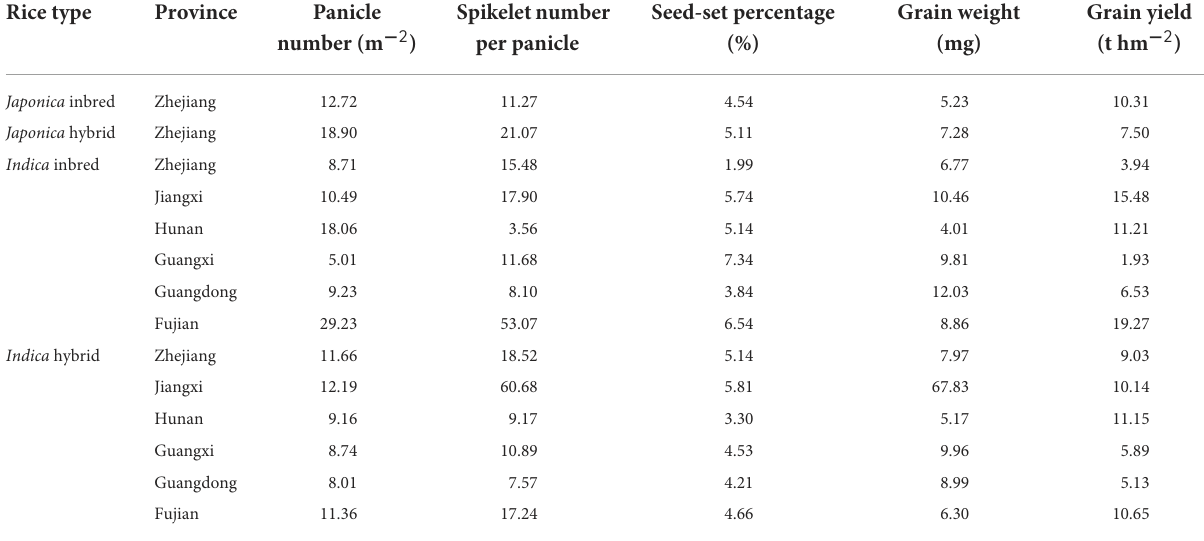
TABLE 5 Changes in variation coefficients for the yield traits of high grain quality rice varieties in different provinces. Rice